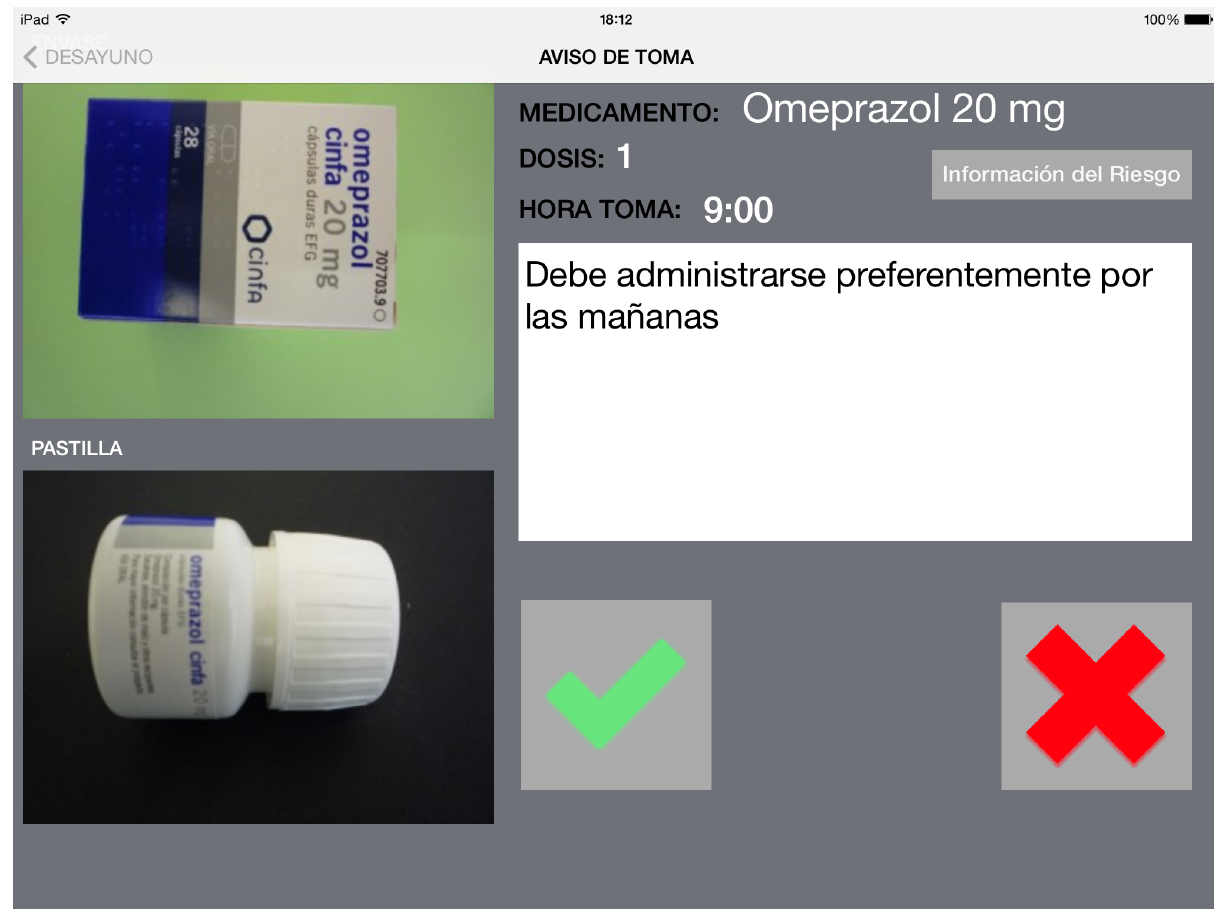
Figure 1. Example of a ALICE